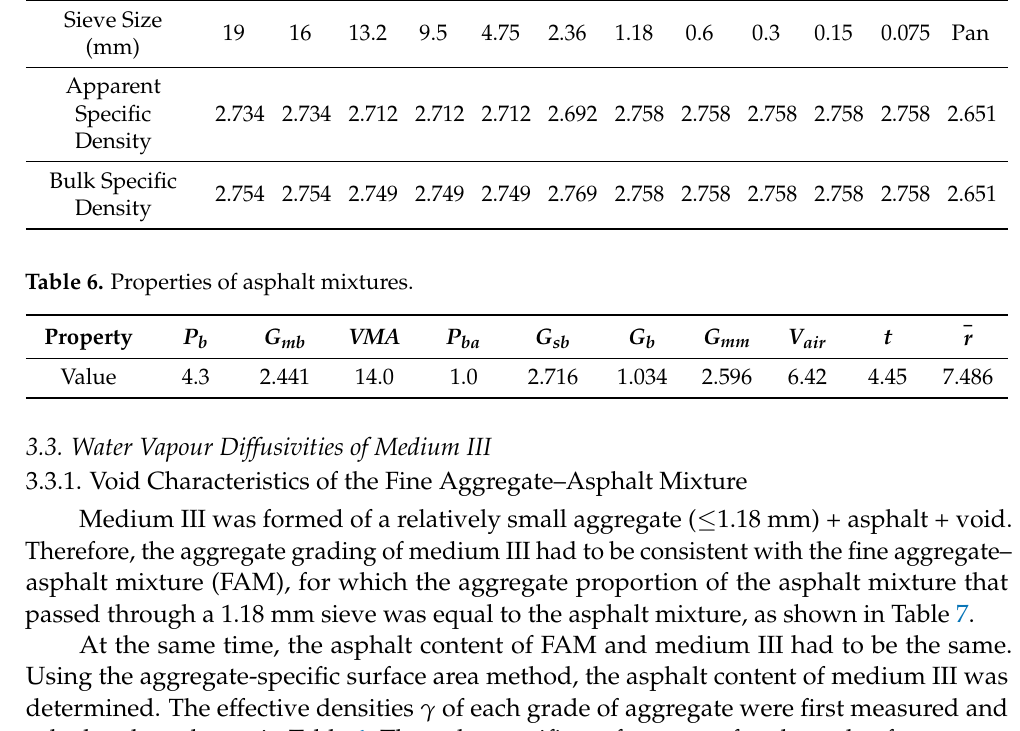
Table 5. Densities of the limestone aggregates used in five types of asphalt mixture.